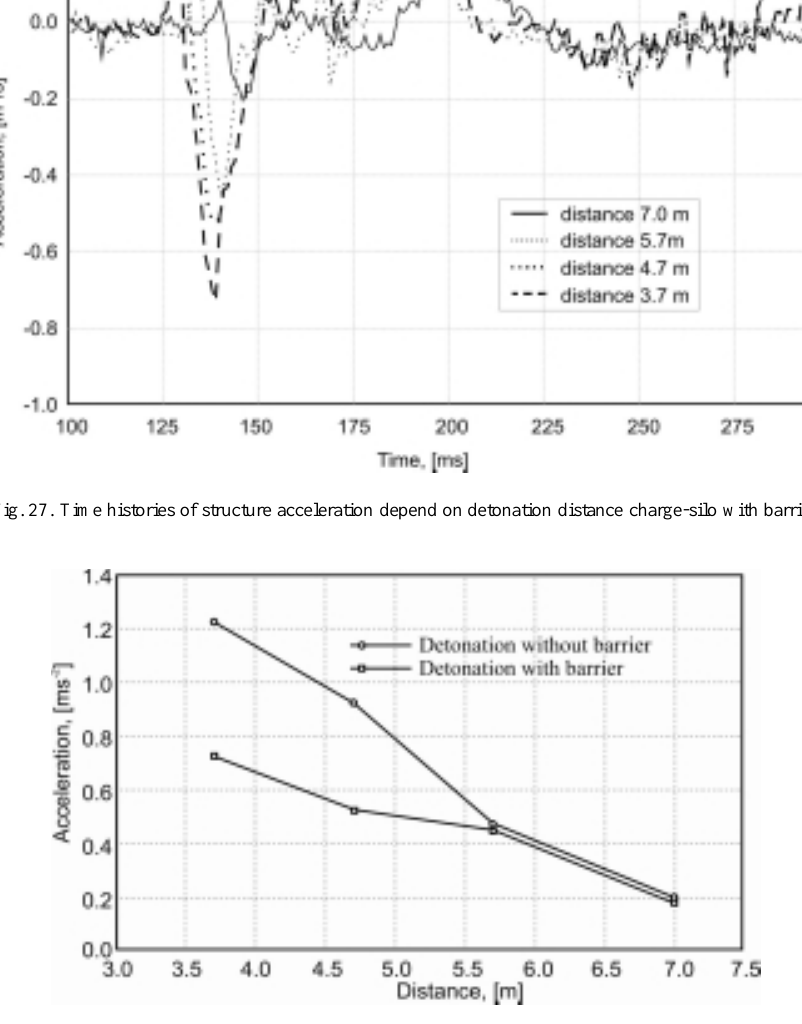
Fig. 28. Barrier influence on structural accelerations vs. charge-to-structure